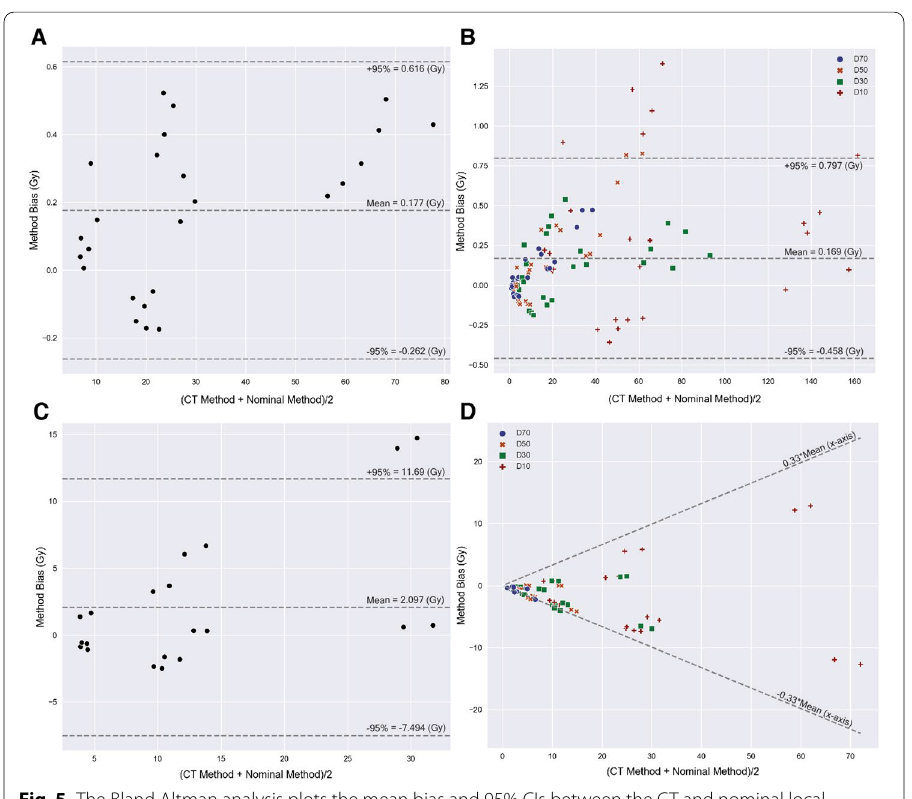
all DVH dose metrics for every calibration of the CT and nominal deposition meth- ods. Its bias was defined as the DVH dose metric of the CT method subtracted by the corresponding DVH dose metric of the nominal method. The mean bias of the liver DVH dose metrics was 0.17 Gy, indicating the DVH doses based on the CT method are slightly greater than those of the nominal method. In contrast, the mean log-ratio